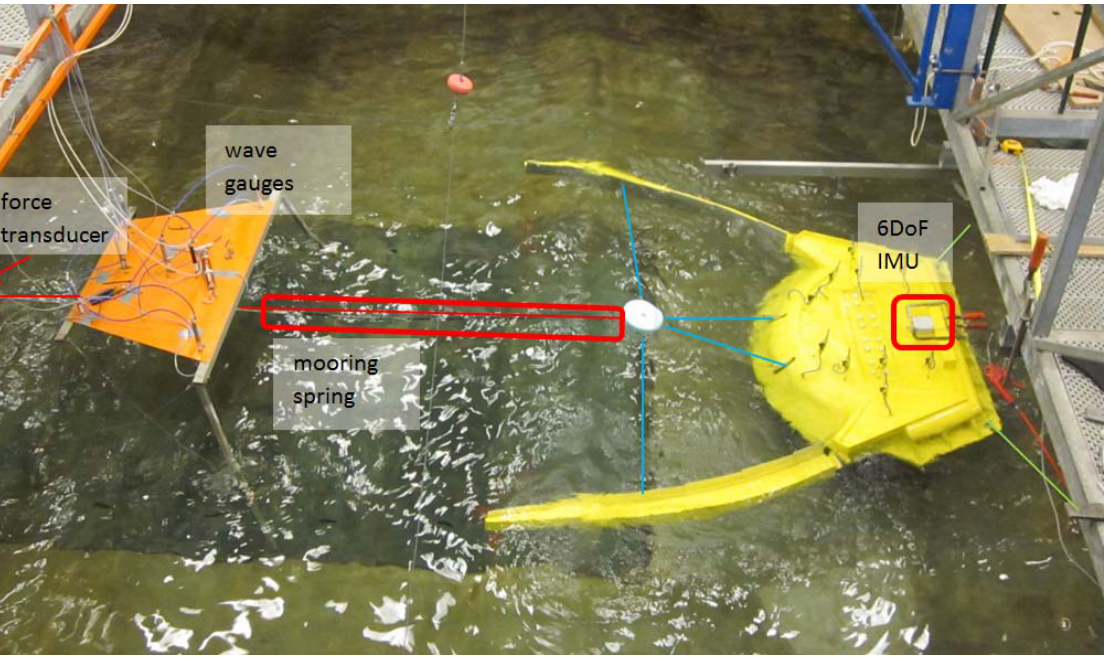
Figure 3. Experimental setup of the 1:50 scale model tests of the North Sea Wave Dragon demonstrator (wave maker is on the left).